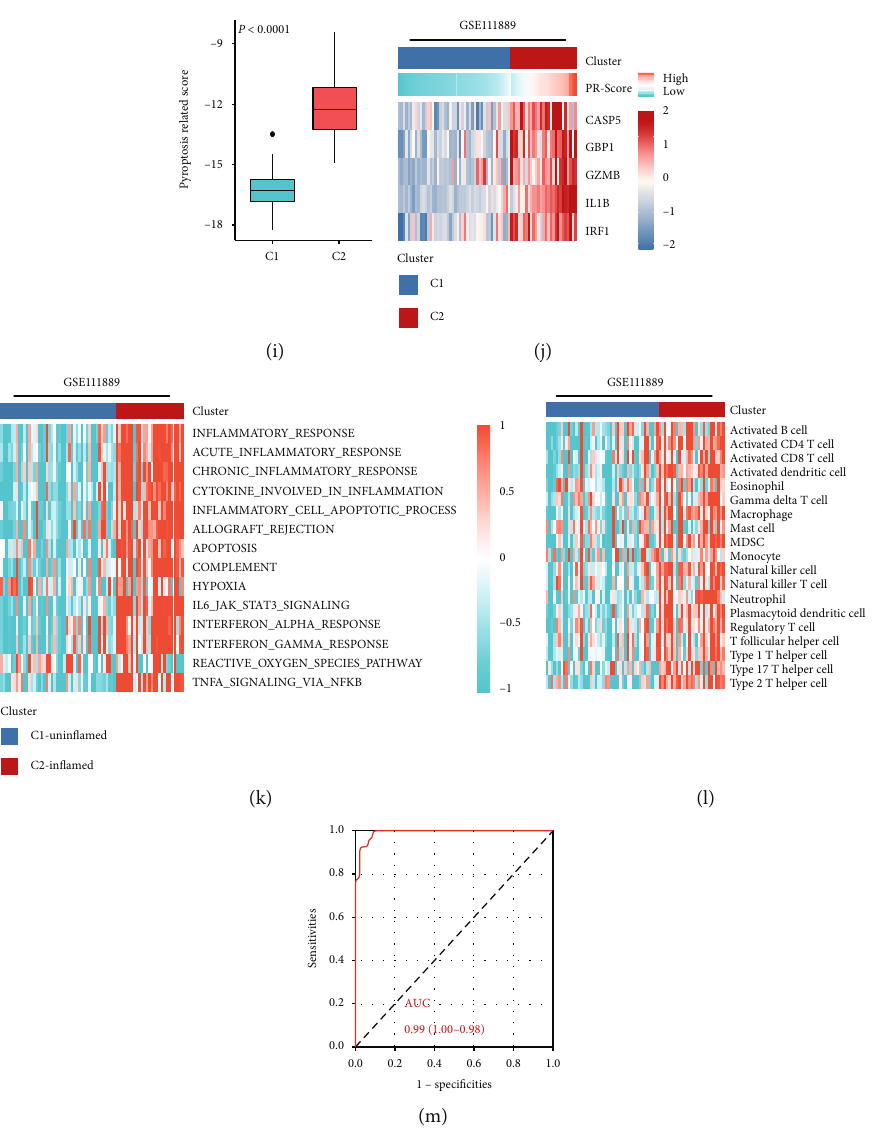
Figure 5: The capacity of PR-signature in classifying active/inactive UC and in fl amed/unin fl amed immune status. (a) Based on the PR- signature, UC samples of the training set were reclassi fi ed into two clusters using unsupervised consensus clustering. (b) Distributions of two clusters in active UC and inactive UC. (c) Distributions of active/inactive UC samples, PR-Score, and expression of the fi ve key PRGs in two clusters. (d) The ROC curve showed the diagnostic e ffi ciency of the PR-signature in three datasets. (e) Di ff erences of activation of in fl ammatory-related pathways in two clusters. (f) Di ff erences of immune cell in fi ltration in two clusters. (g) UC samples of GSE111889 were classi fi ed into two clusters based on the PR-signature using unsupervised consensus clustering. (h) Expression di ff erences of the fi ve key PRGs in two clusters. (i) Di ff erences of the PR-Score in two clusters. (j) Distributions of PR- Score and expression of the fi ve key PRGs in two clusters. (k) GSVA showed the distributions of the in fl ammatory-related pathways in two clusters. Orange represents activation of biological pathways and blue represents inhibition of biological pathways. (l) The distributions of immune cells in two clusters. Orange represents abundant in fi ltration and blue represents immune cell desert. (m) The ROC curve showed the diagnostic e ffi ciency of the PR-signature for two clusters. UC: ulcerative colitis; ac: active; in: inactive; AUC: area under the